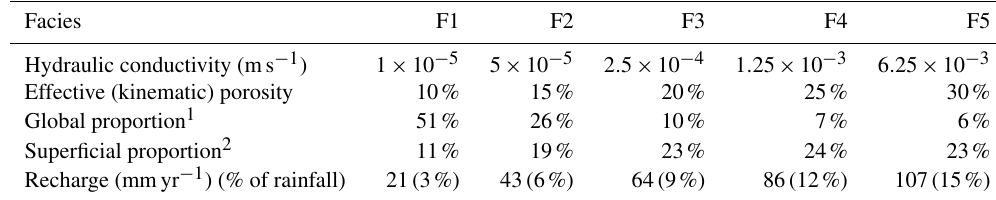
Table 1. Synthetic hydrofacies parameters. Facies